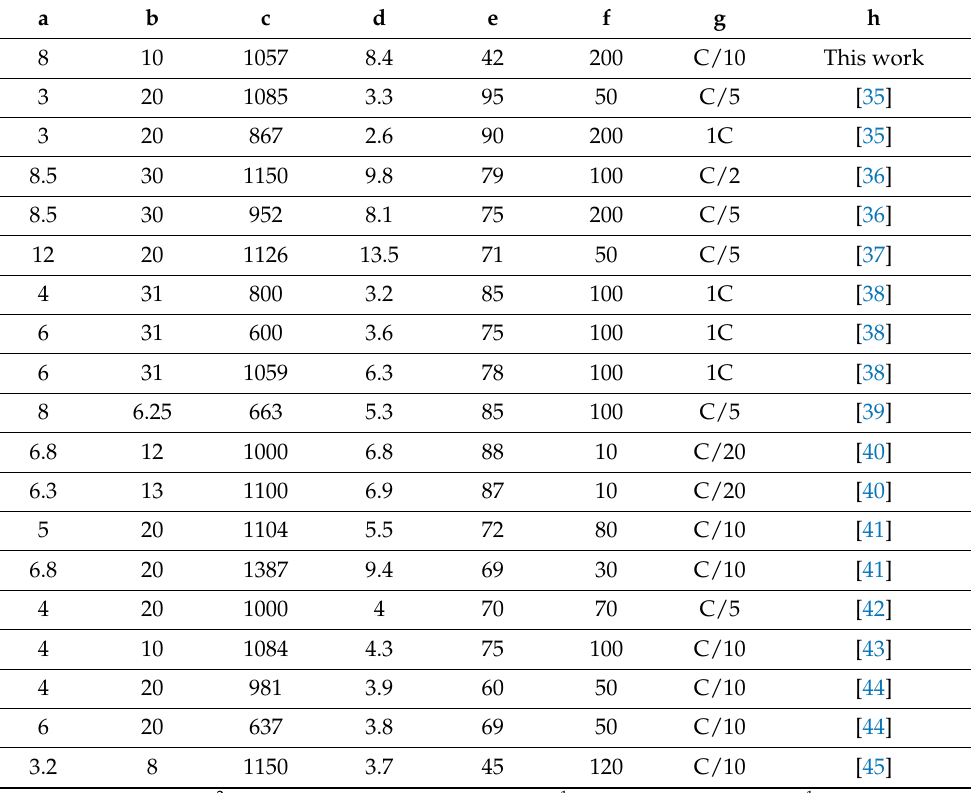
Table 3. Comparative analysis of the battery performances and electrochemical characteristics of the high-loading sulfur cathode